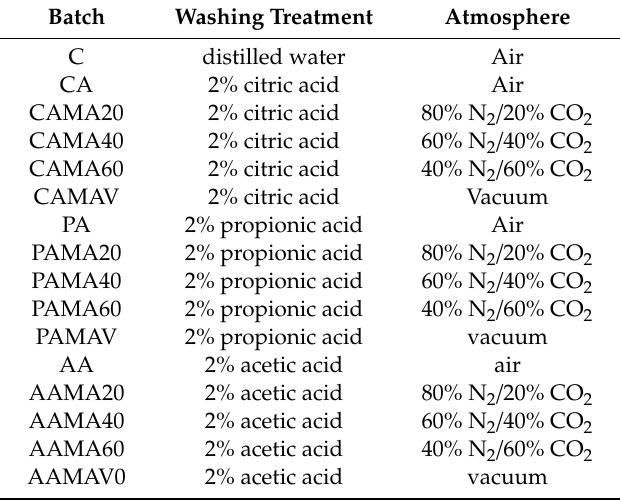
Table 1. Washing treatment and atmosphere composition of di ff erent chicken leg